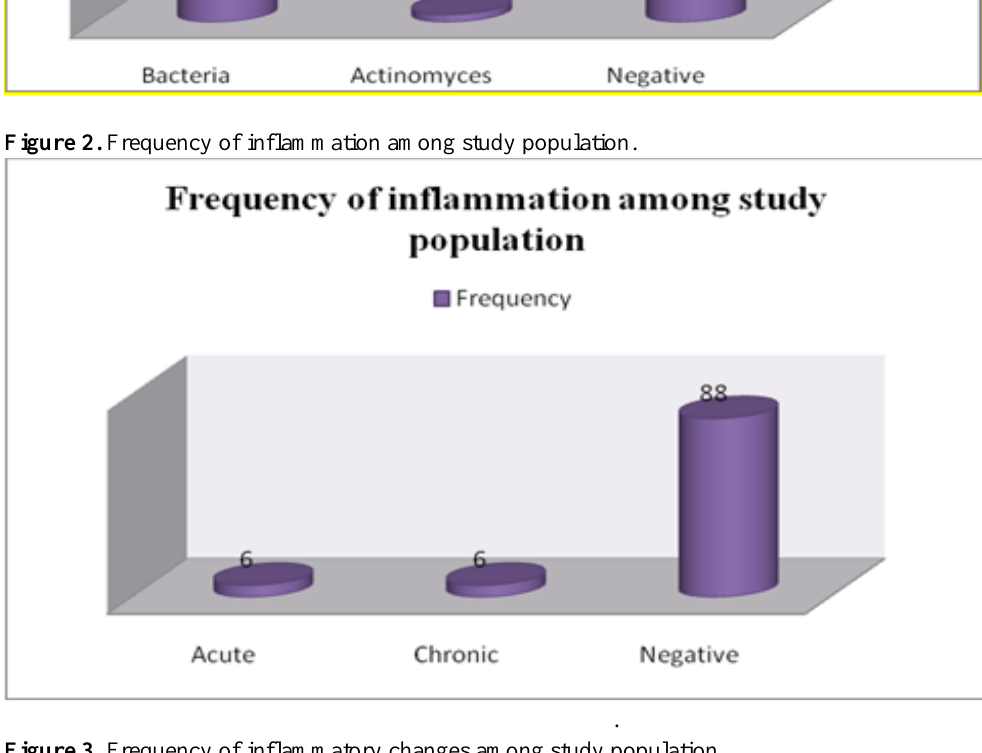
Figure 3. Frequency of inflammatory changes among study